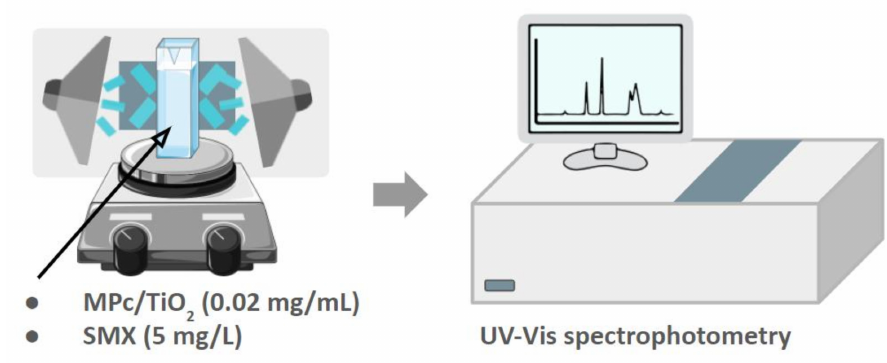
Figure 4. Set-up of the photocatalytic experiment in DMF.